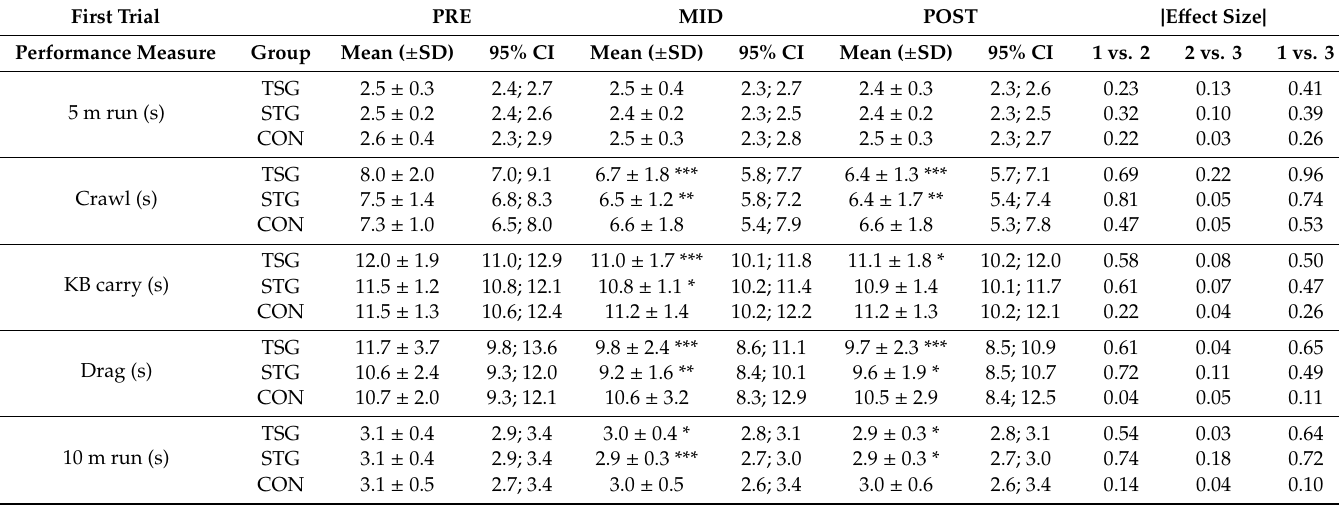
Table 3. Simulated military task performance times for di ff erent tasks (first 5 m run, crawl, kettlebell carry (KB), casualty drag, and final 10 m run) from the first trial in the PRE, MID, and POST measurements points.